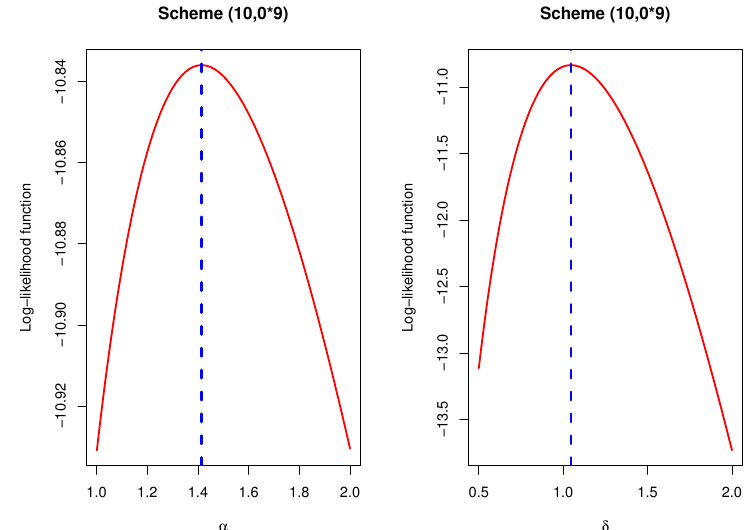
Figure 7. The log-likelihood functions of α and δ using scheme ( 10,0 ∗ 9 ) for electrical appliances data. Via the M-H algorithm sampler, from 30,000 MCMC samples with 5000 burn-in, the Bayes estimates with their SEs of α , δ , R ( t ) , and h ( t ) (at time t = 0.5) are developed under SEL and LL (for η (= − 3, − 0.03, + 3 ) ) functions using non-informative prior. Additionally, the lower and upper bounds of the 95% ACI/HPD credible interval estimates with their interval lengths are also calculated. The MLEs of α and δ are chosen as the initial guesses to apply the M-H algorithm. All point and interval estimates of α , δ , R ( t ) , and h ( t ) are reported in Tables 6 and 7, respectively. It is clear, from Tables 6 and 7, that the point estimates of α , δ , R ( t ) , and h ( t ) obtained by both likelihood and Bayesian estimation methods are quite close to each other. A similar pattern is also observed in the case of interval estimation using ACIs and HPD credible intervals.